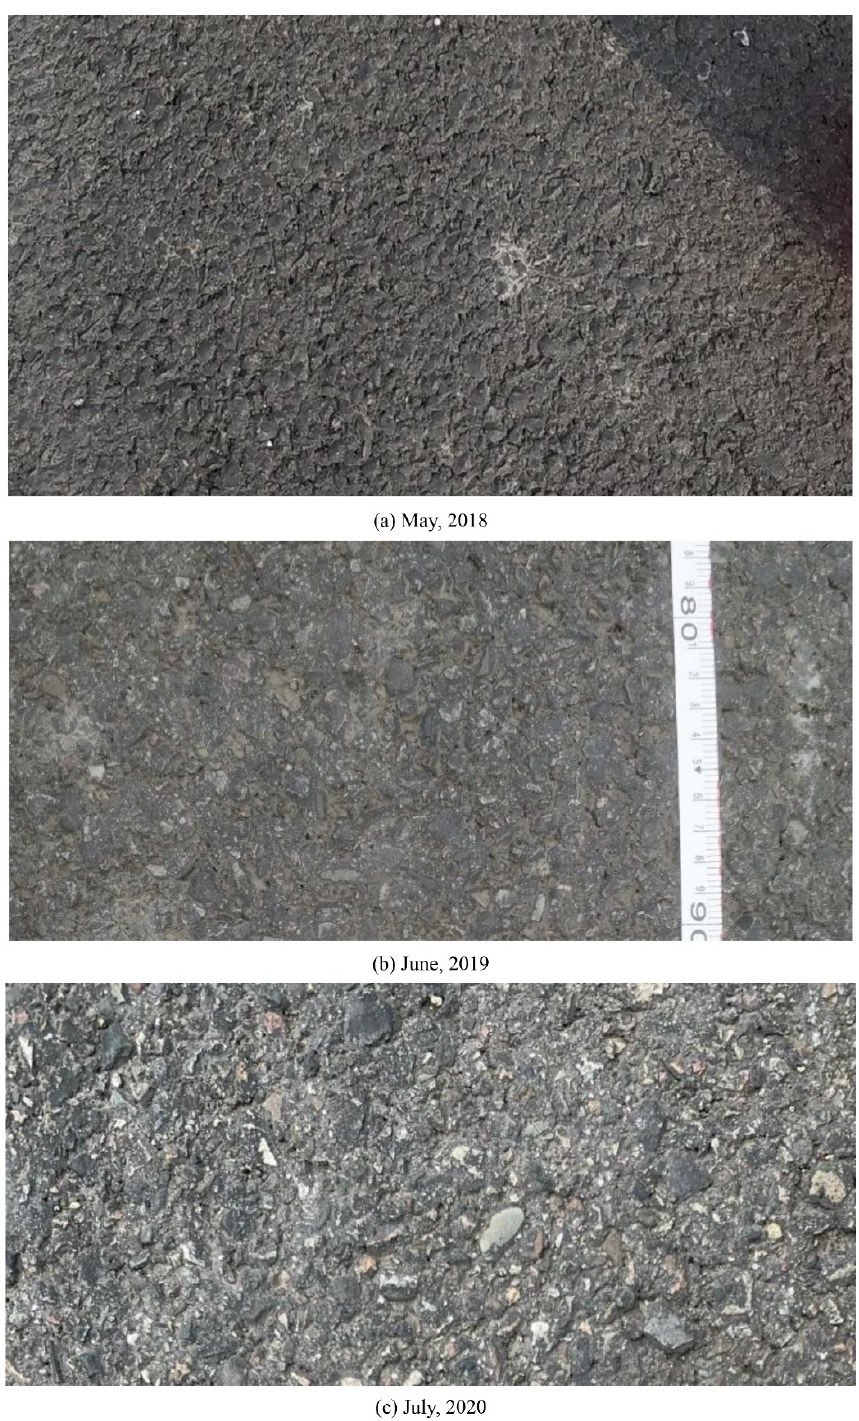
Figure 1. Pavement surface pictures from the field site: ( a ) May, 2018, ( b ) June, 2019, and ( c ) July, 2020.